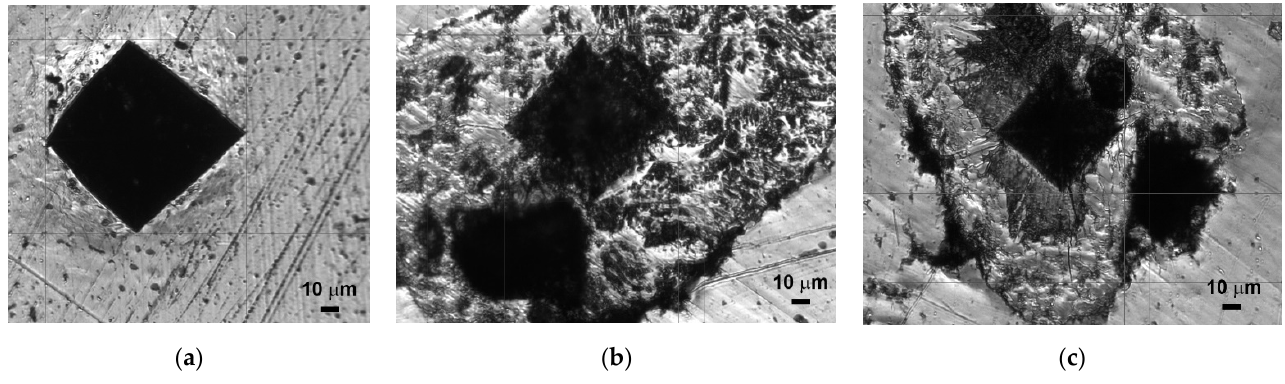
Figure 3. SEM images of indentations made in the surfaces of 51Fe–32Cu–9Ni–8Sn matrices with different contents of nano-VN additive: ( a ) Sample 1 without VN addition; ( b ) Sample 6 with 4 wt.% of nano-VN; ( c ) Sample 9 with 10 wt.% of